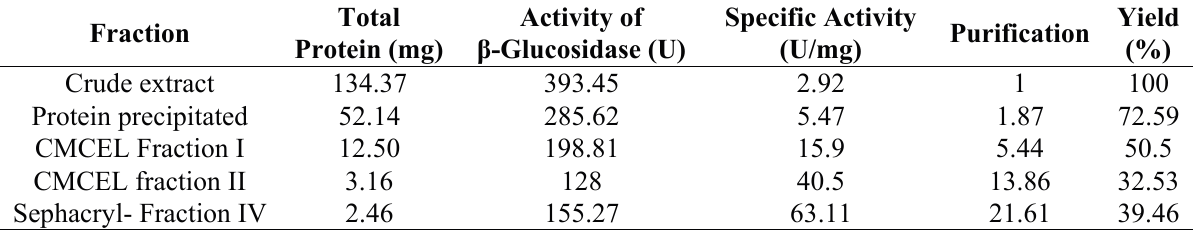
Table 1. Purification chart for β -glucosidase in Sechium edule , from 200 g of pulp, homogenized in acetate buffer at pH 5.0.